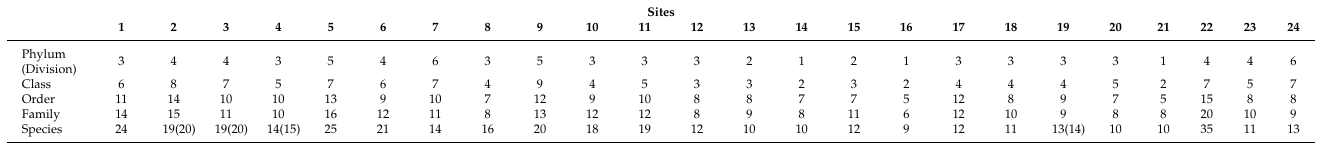
Figure 2. Taxonomic spectrum of phytoplankton in the Siversky Donets river basin (Ukrainian part). Table 3. Taxonomic composition of phytoplankton in the Siversky Donets river basin. Sites